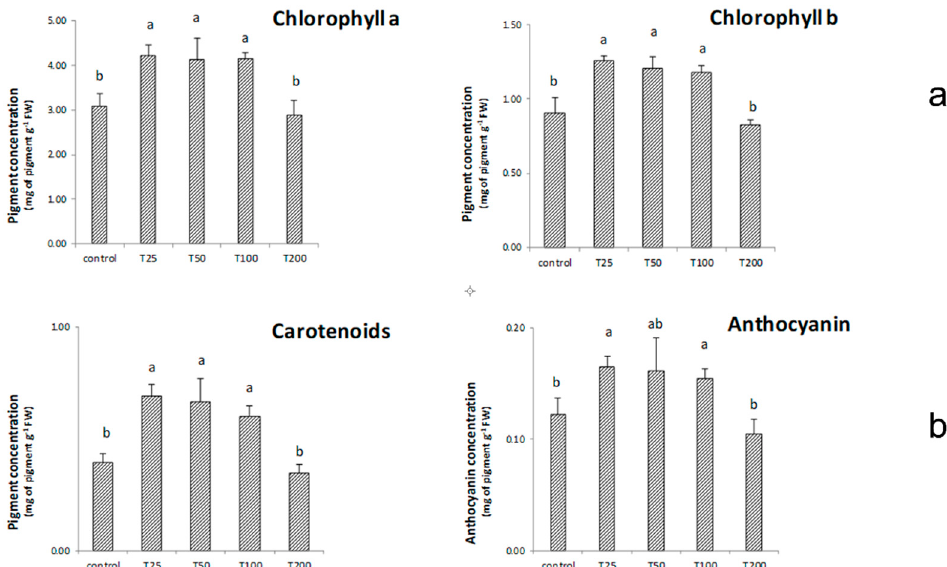
Figure 5. Shoot ( a ) and root ( b ) length recorded at 14 days after the treatments in maize seedlings subjected to the treatments with biogenic ZnO-NPs (T25, T50, T100 and T200) compared to the untreated control samples. Letters in the figure, when different, indicate statistically significant differences for p < 0.05 between treatments.